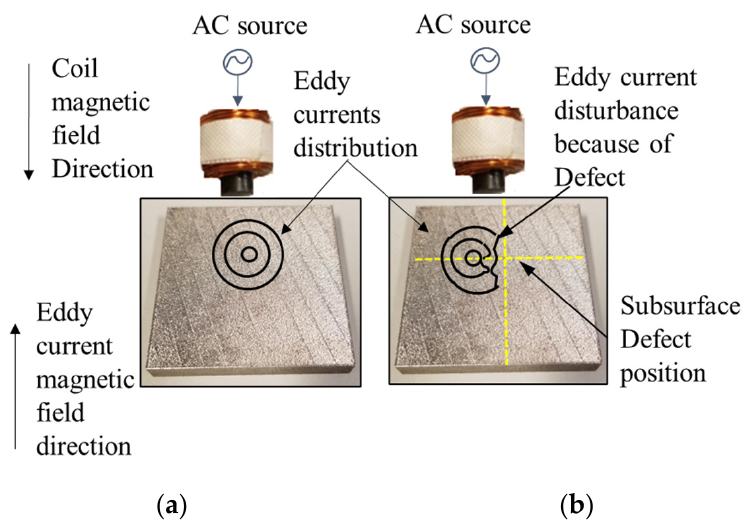
Figure 1. Schematic Eddy currents distribution under a coil on top of a stainless-steel plate; ( a ) shows the distribution of eddy currents in case no defect, ( b ) shows the perturbation of eddy currents due to an artificial surface crack in the plate.